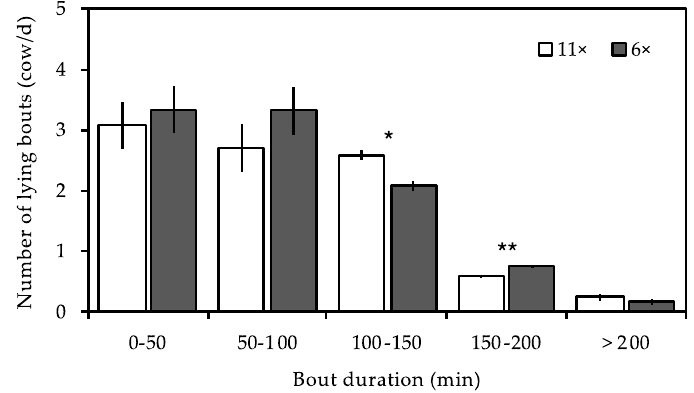
Figure 4. Distribution of lying bouts duration. Cows were monitored under two feed delivery frequencies (11 × and 6 × ). Data are the average of the two periods for each feed delivery frequency. The error bars represent ± 1 SE of the mean. Statistical differences between feed delivery are indicated with **( p < 0.01) and *( p < 0.05).